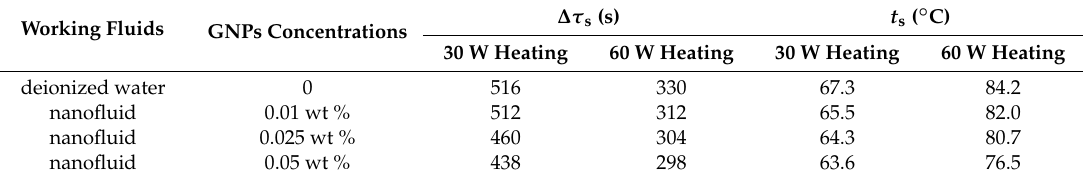
Table 2. The start-up time for solar heat pipes under heating powers of 30 and 60